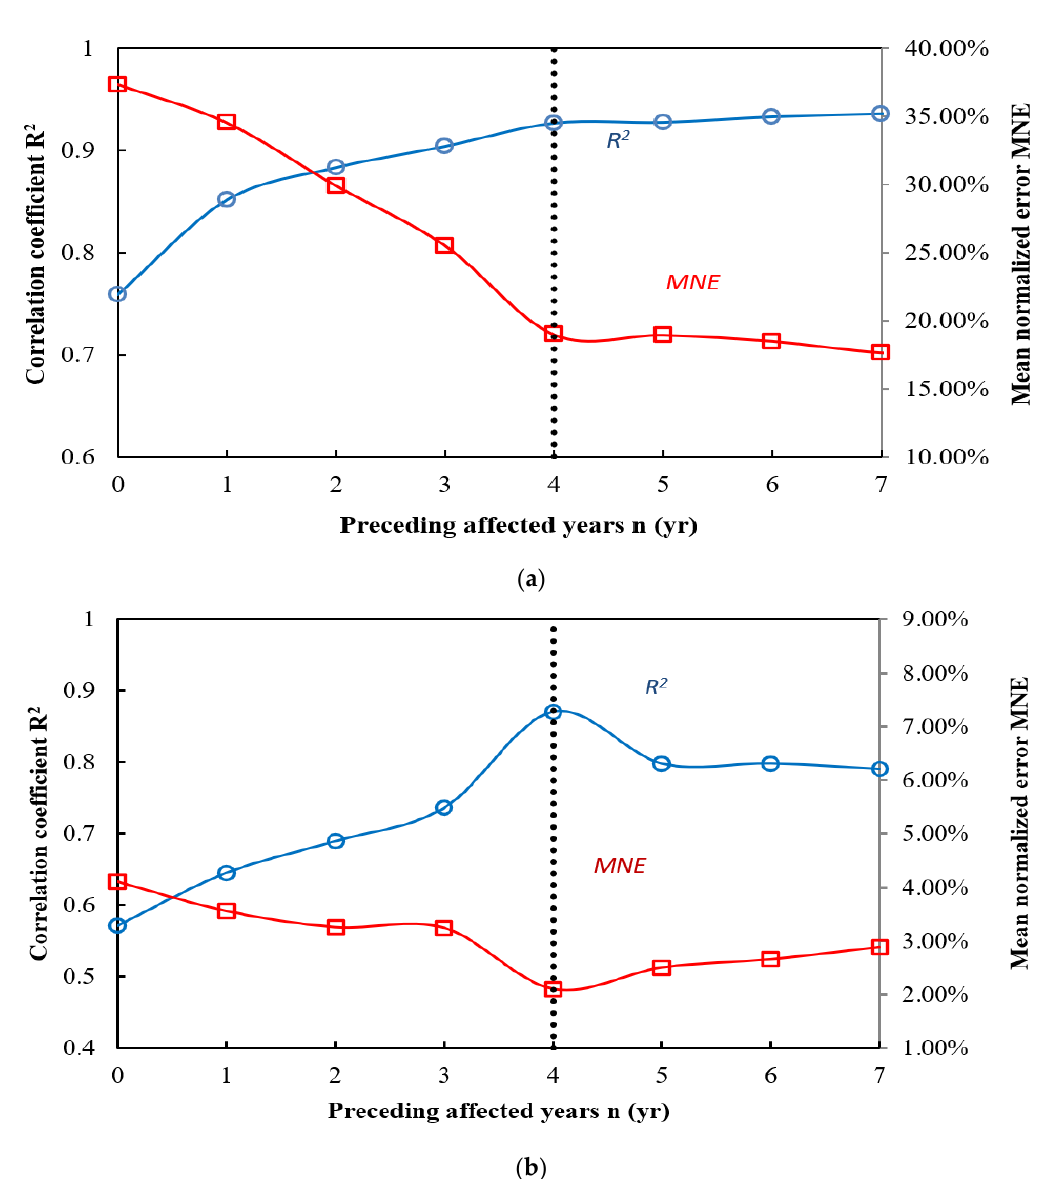
Figure 9. Comparison of the calculation results of the longitudinal and lateral stability indexes of the Wuhan reach using the DRM. ( a ) Cumulative erosion. ( b ) Distance from the thalweg to the initial point. Table 4. Fitting parameters, correlation coefficient, MNE, and p -values of the longitudinal and lateral stability indexes of the Wuhan reach using the DRM. Indexes p Cumulative erosion 0.003 < 0.01 Distance from thalweg to initial